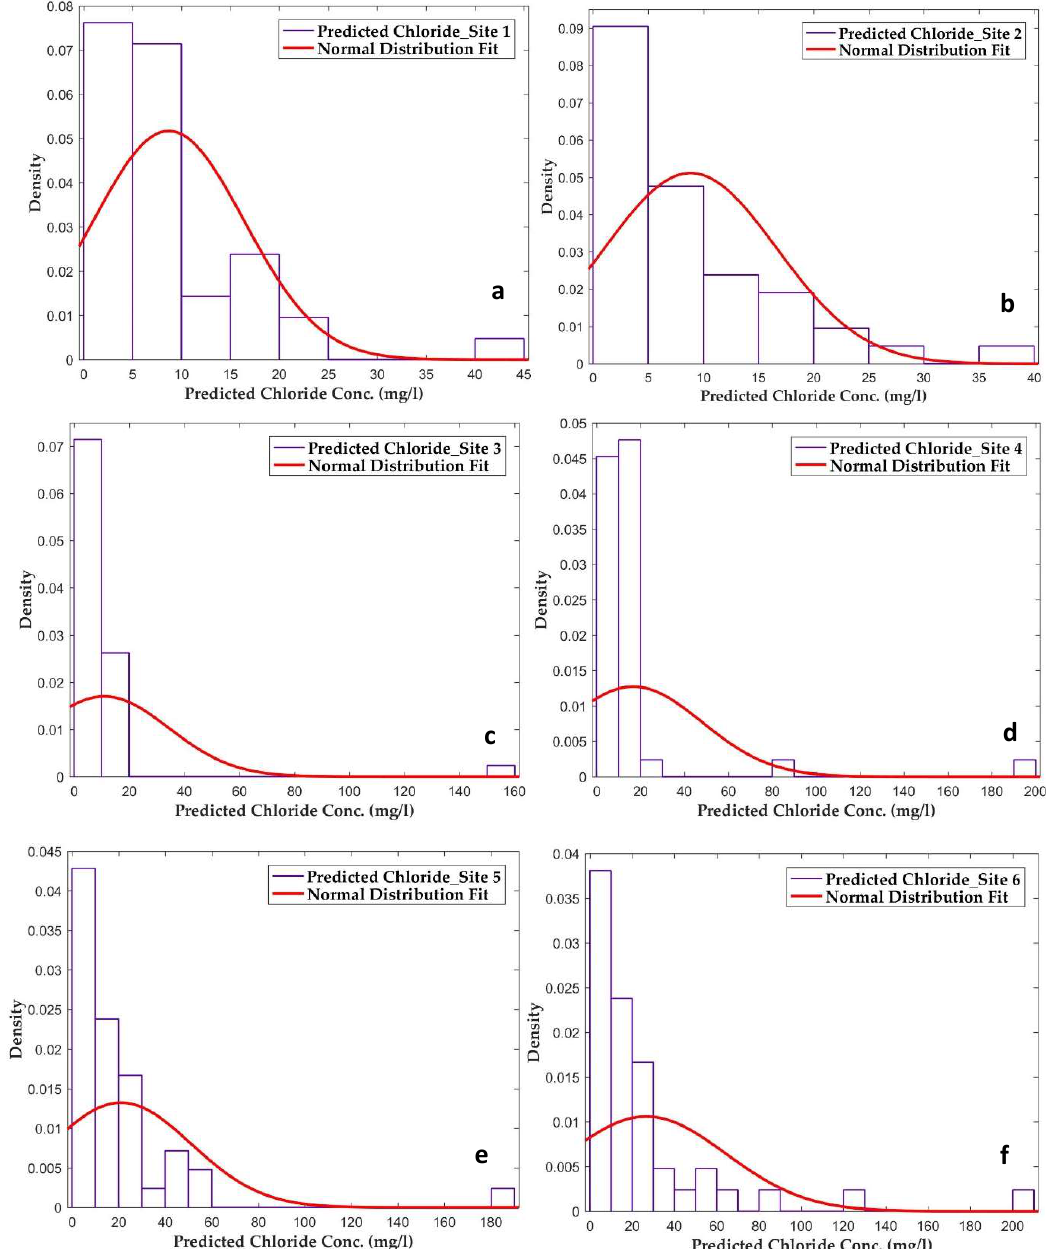
Figure 7. Density distributions (ANN outputs) for chloride concentrations at all sites ( a ) Site 1, ( b ) Site 2, ( c ) Site 3, ( d ) Site 4, ( e ) Site 5, and ( f ) Site 6 reveal shifting means. Spatial distribution covered <50% for site 1, 2, 3 and 4 whereas site 5 and 6 covered >70% of predicted chloride.